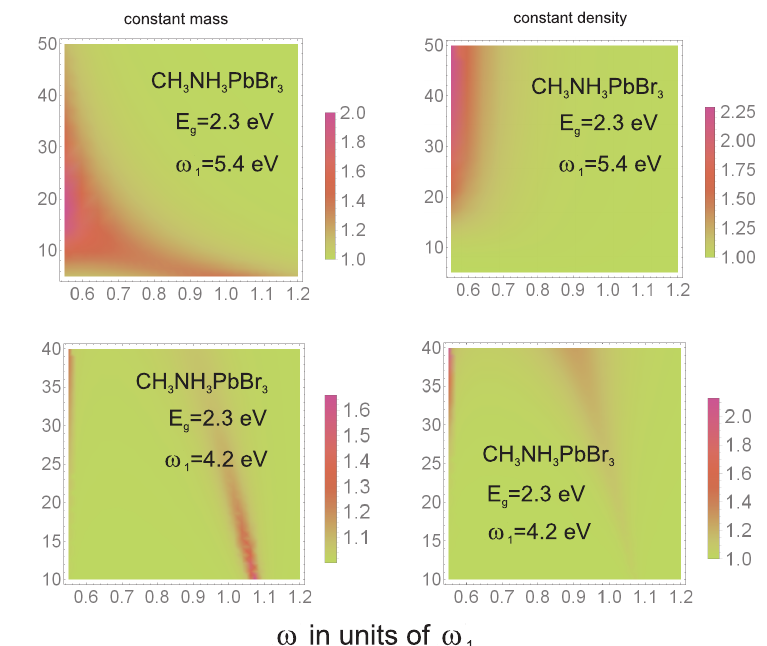
Figure 11. Density plots of 1 + q m as a function of frequency ω / ω 1 of incident photons and of q 0 nanoparticle radius, a , in accordance with Equations (4) and (9) (this ratio displays an increase in the light absorption, aided by plasmons, normalized to the photo-absorption without the mediation of metallic components) for a large-gap perovskite cell (adjusted to a large-gap plasmonic frequency of 4.2 eV and 5.4 eV for the gap of 2.3 eV). The graphs indicate that it is possible to increase the absorption of perovskite cells in the UV region using metallic nanoparticles with smaller radii than of those needed for Si cells; see Figure 10. For higher-gap perovskites, a higher energy plasmon resonance than that obtained in Au nanoparticles is needed. The latter is caused by the frequency cut-off of the gap, whereas a smaller radius is required to compensate for the growth of the effective masses of electrons and holes in perovskite compared to Si cells to maintain a similar damping rate to that given in Equation (8). Constant density refers to a fixed surface density of metallic nanoparticles, at 5 10 9 /cm 2 regardless of the variation in nanoparticle size, whereas constant mass indicates a × fixed total mass of metal, distributed in the form of nanoparticles with varying sizes and thus with larger concentrations for smaller radii (Mathematica